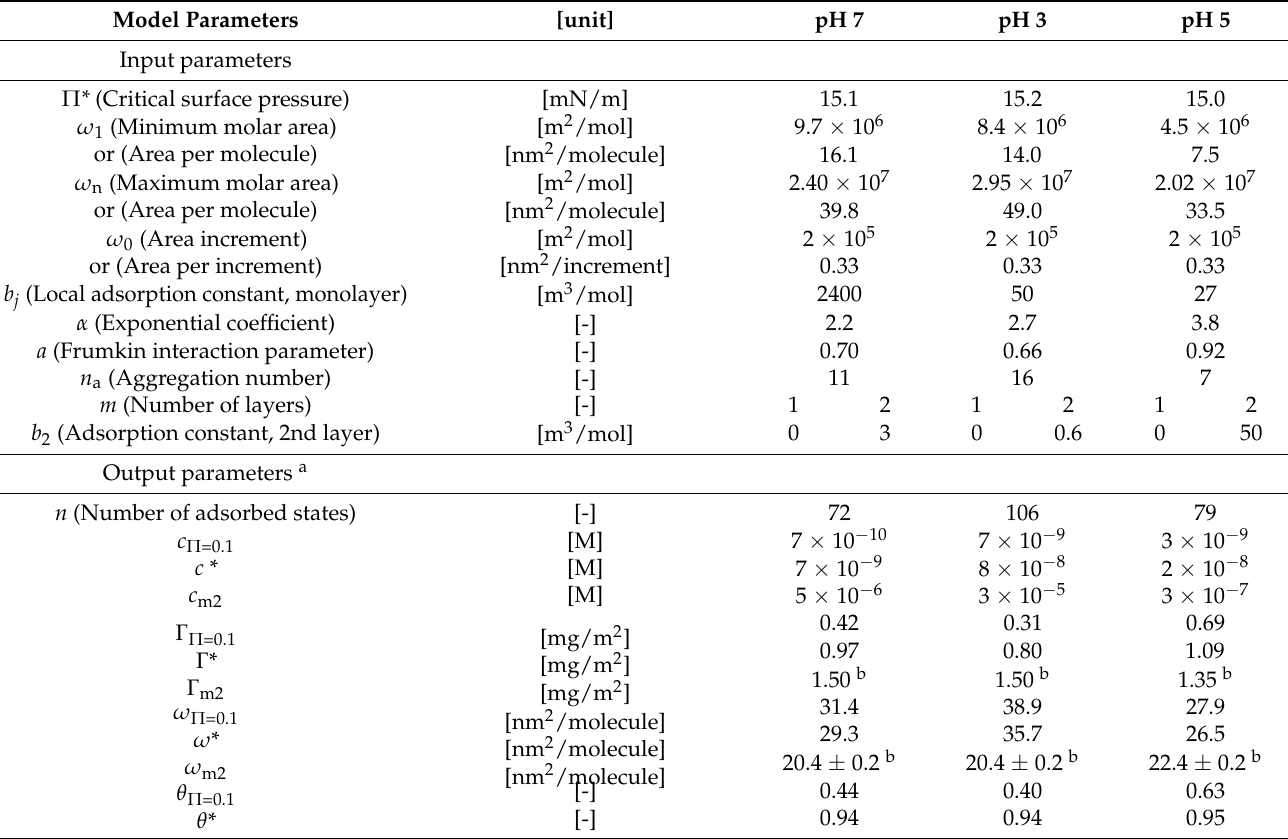
Table 1. Values for input model parameters used for obtaining the best fits to the experimental data at different pH. Values for some output parameters obtained from the best fits are also